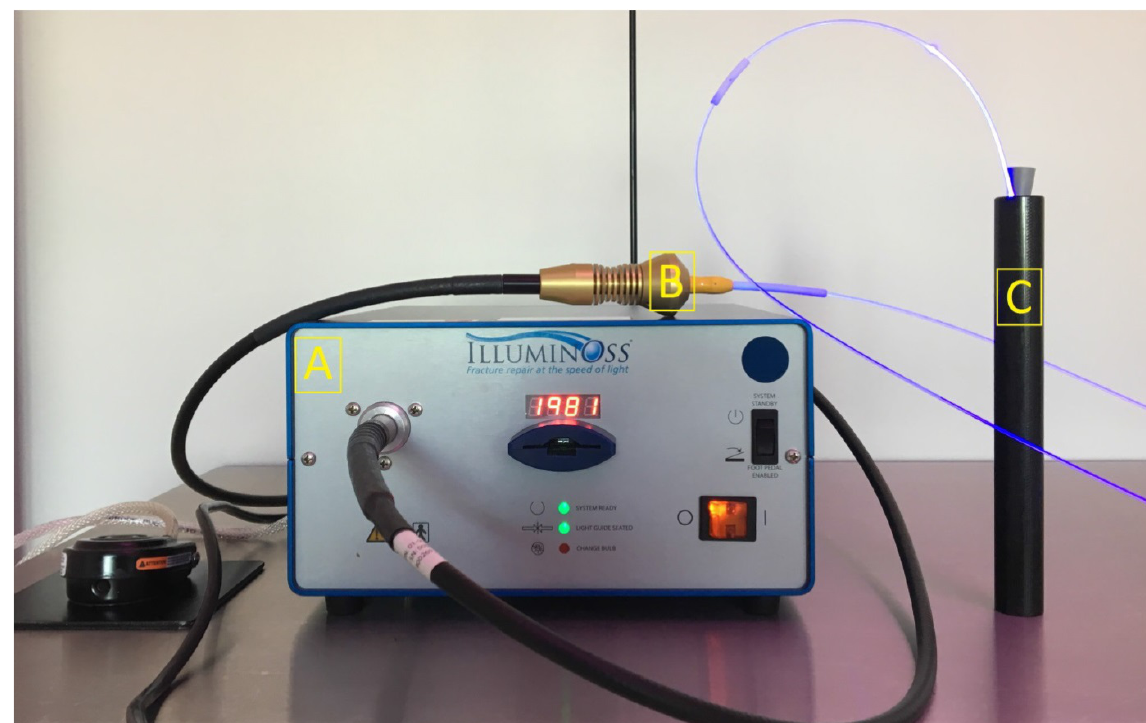
Figure 2. Test set-up. A: System light source. B: Light source to light catheter connection. C: Delrin cylinder (simulating bone and intramedullary space) with S. aureus suspension and implant getting exposed to blue light.